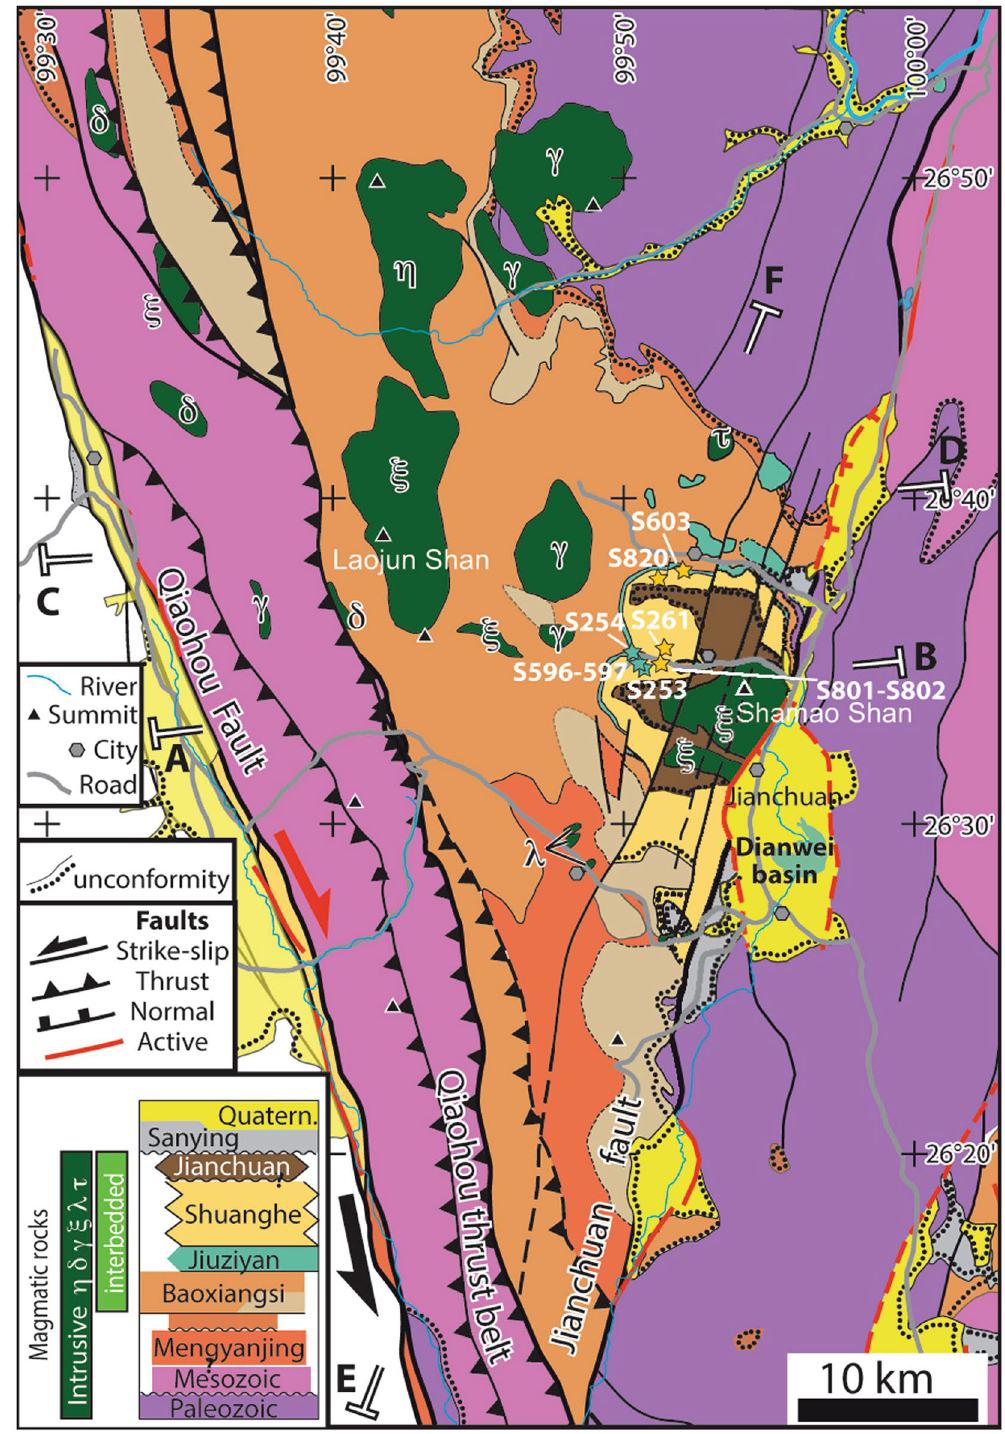
Figure 2. Revised Cenozoic stratigraphy for the Jianchuan basin and structural map of the Jianchuan basin (modified after 11). The inset in the lower-left corner depicts the geometrical and temporal sedimentary relationships between the formations, with undulations corresponding to angular unconformities. Sites S253, S254, S261, S596, S597, S603, S801, S802 and S820 (stars) refer to locations referred to in the text and figures. Magmatic rocks lithology: ξ syenite, δ diorite, γ granite, η norite, τ trachyte. Quatern: Quaternary. The lithology of Paleogene formations from the Jianchuan basin is detailed in the text. Base map obtained from Bureau of Geology and Mineral Resources of Yunnan Province 52 . This figure was generated using MAPublisher 9.9 (http:// www.avenza.com/mapublisher) under Adobe Illustrator CS6